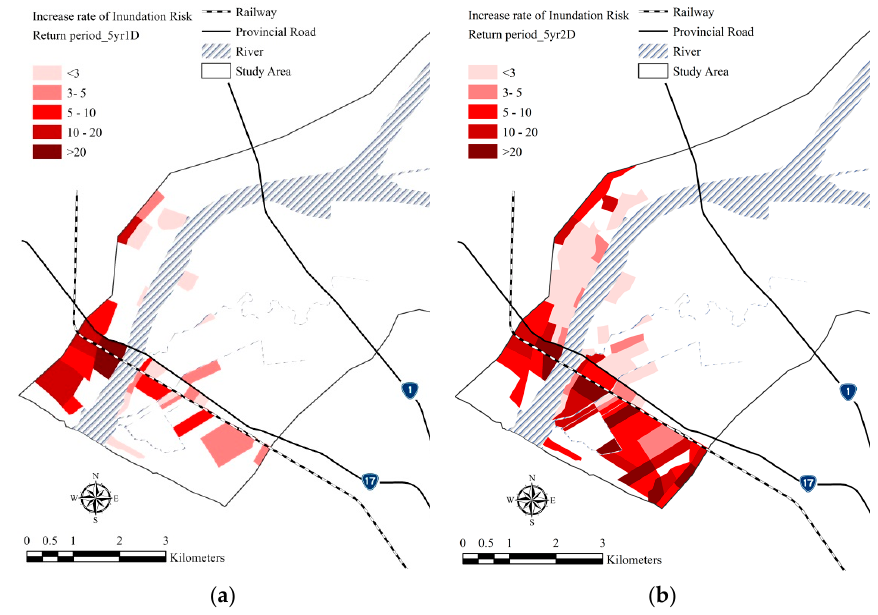
Figure 15. ( a ) Distribution map of inundation risk increase after land subsidence and A1B-S scenario for a one-day storm under a 5-year return period; ( b ) Distribution map of inundation risk increase after land subsidence and the A1B-S scenario for a two-day storm under a 5-year return